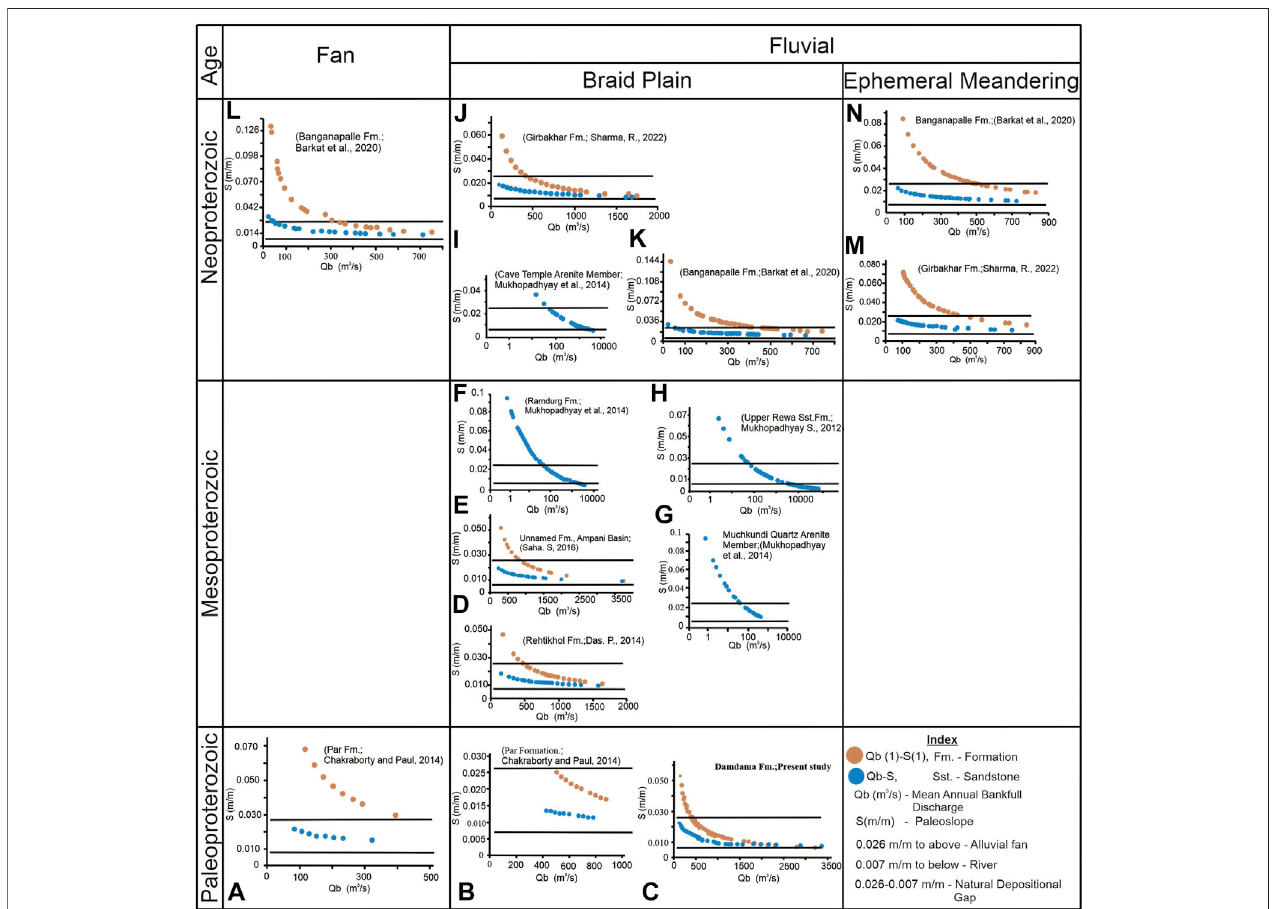
FIGURE 4 | Binary plots of palaeoslope (S) and mean annual bankful discharge values (Qb) were calculated from alluvial deposits (fan, braid plain and ephemeral meandering) of Indian Precambrian basins ( (A,B) Par Formation Gwalior basin. (C) Damdama Formation, Bayana basin. (D) Rehtikhol Formation, Singhora basin. (E) Unnamed Formation, Ampanibasin. (F) Ramdurg Formation, Bagalkot Group. (G) Muchkundi Quartz Arenite Member, Badami Group. (H) Upper Rewa Sst,Formation, Vindhyan Supergroup. (I) Cave Temple Arenite Member, Badami Group. (J,M) Girbakhar Formation, Marwar Supergroup. (K,L,N) Banganapalle Formation, Kurnool Group). NoteslopevaluesfallingintheNatural DepositionalGap(0.007 m/mto0.026 m/m) inmostofthecases.Also,notelowtoverylowdischarge inmostof the cases and very high discharge in the Rewa fl uvial system.